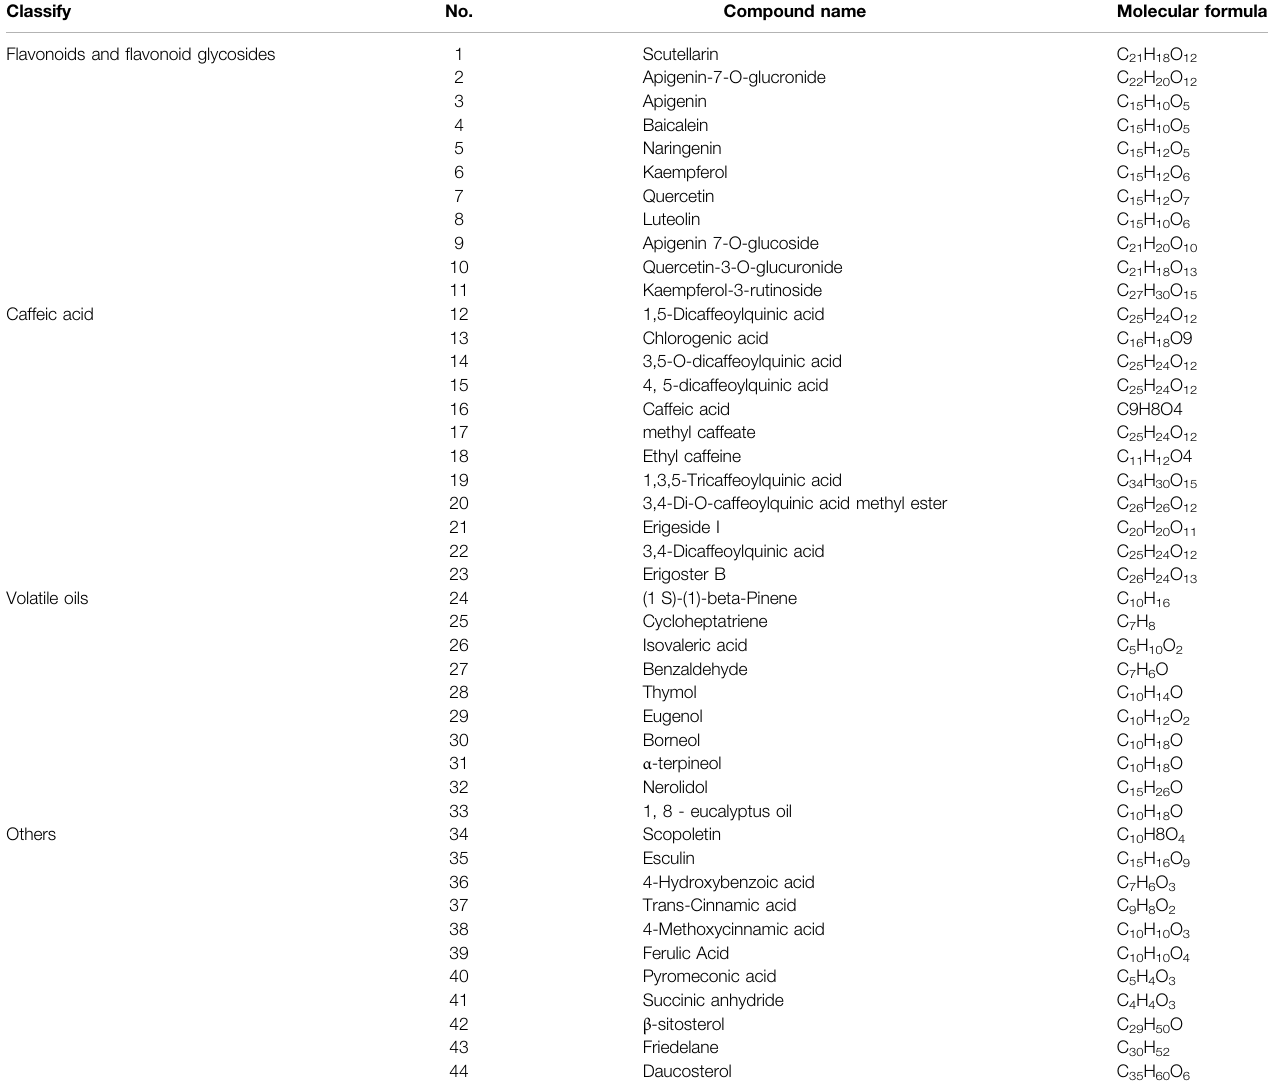
TABLE 1 | Some typical chemical components in four types of DZXX. Classify No. Compound name Molecular formula Flavonoids and fl avonoid